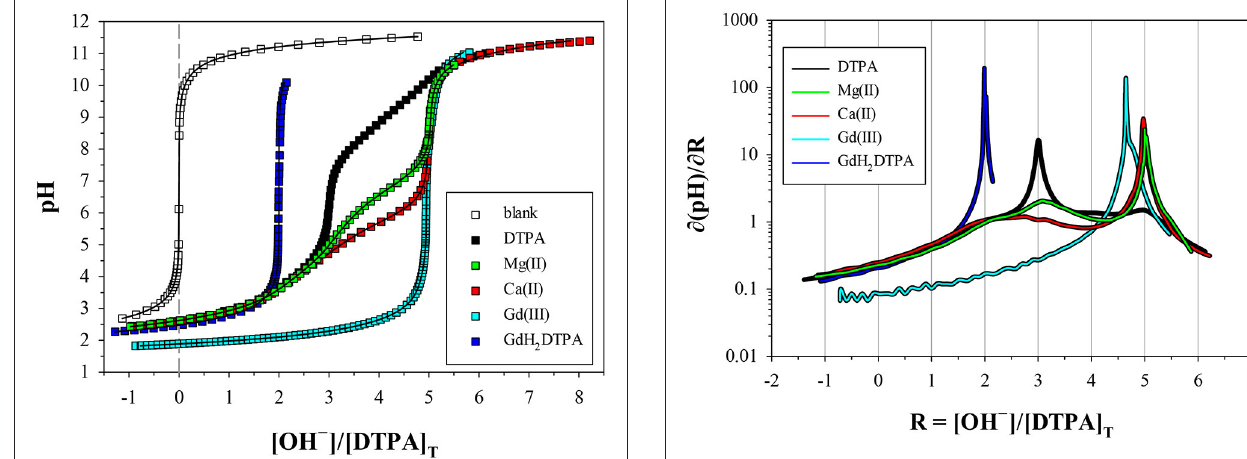
FIGURE 3 | Potentiometric titrations of DTPA and metal + DTPA solutions in 0.7M NaClO 4 , where pH is plotted against moles of base (OH − ) added per mole of DTPA. The more a metal titration deviates from that of DTPA alone, the higher the stability of the DTPA complexes formed. Symbols are measurements. Solid lines are non-linear regressions performed with FITEQL4.0. The blank consists of the acidified background electrolyte (0.7M NaClO 4 /HClO 4 ). All other solutions contain 2mM DTPA, except the Gd titration (4mM). The M:L ratios are 1.06 for Mg, 1 for GdH 2 DTPA, and 1.65 for Ca. The curve for the Gd titration, with an M:L ratio of 0.85, was scaled to overlap the Mg and Ca curves.